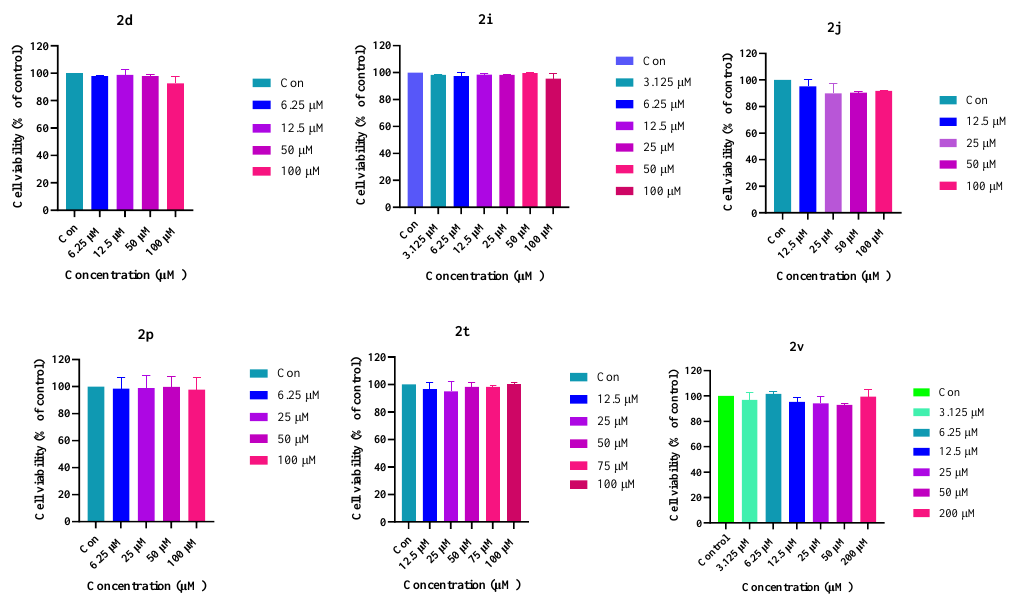
Figure 4. Cytotoxicity of 2d , 2i , 2j , 2p , 2t and 2v on the proliferation of L929 cells (MTT method).